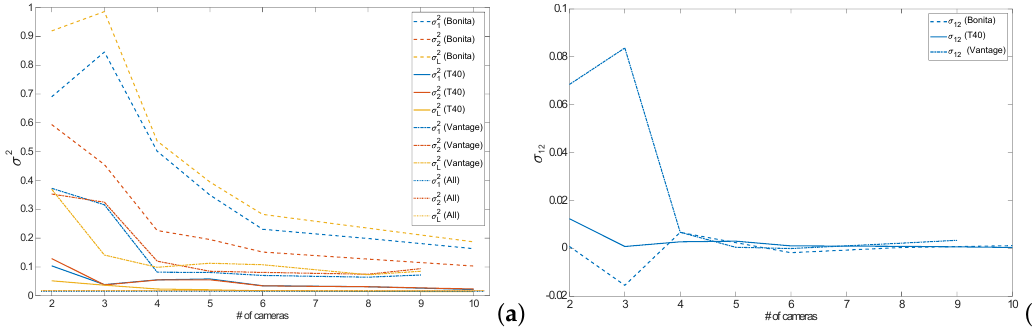
Figure 11. Variances ( a ) and covariances ( b ) for variable numbers of cameras of different